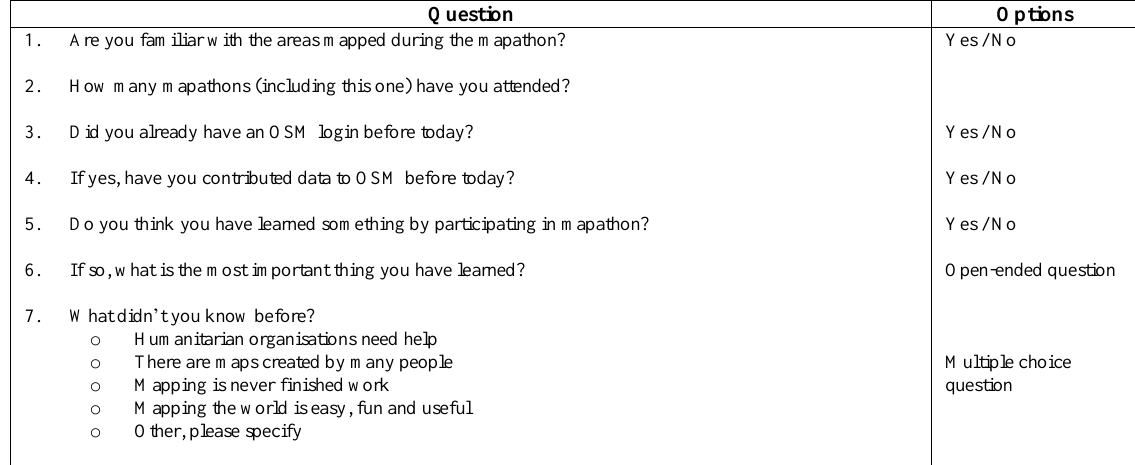
Table 2. Questionnaire on motivations and